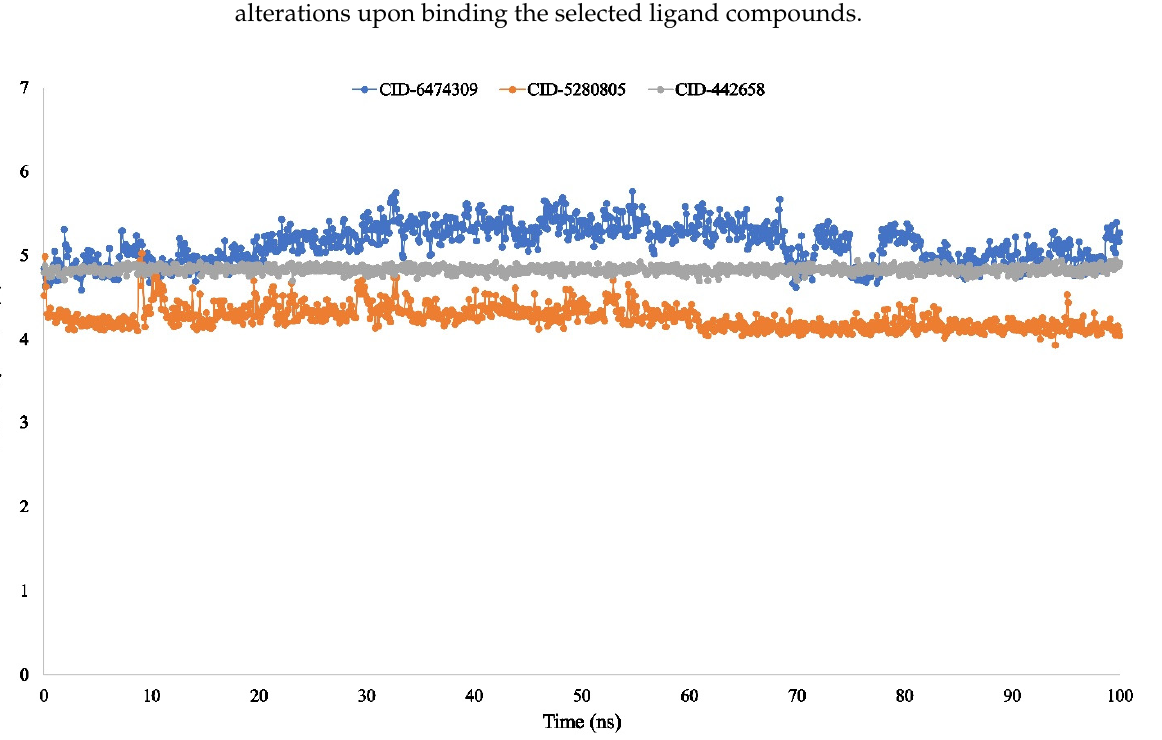
Figure 9. The 100 ns simulation was performed to determine the radius of gyration (Rg) of the protein-ligand interaction. The selected three ligands compound 4,5-di- O -Caffeoylquinic acid (CID- 6474309), rutin (CID-5280805), and schaftoside (CID-442658) in association with the selected protein are depicted by green, orange, and grey, respectively.